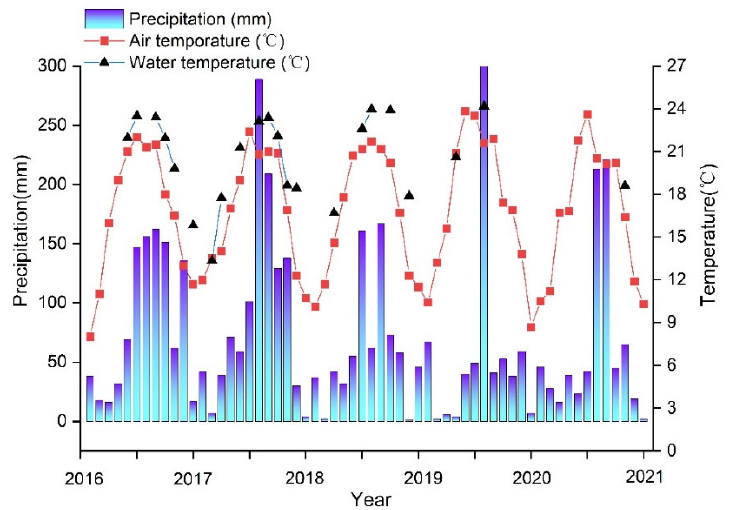
Figure 2. Monthly average air temperature and precipitation of Lake Xingyun from 2016 to 2020 (data provided by the Jiangchuan meteorological station).